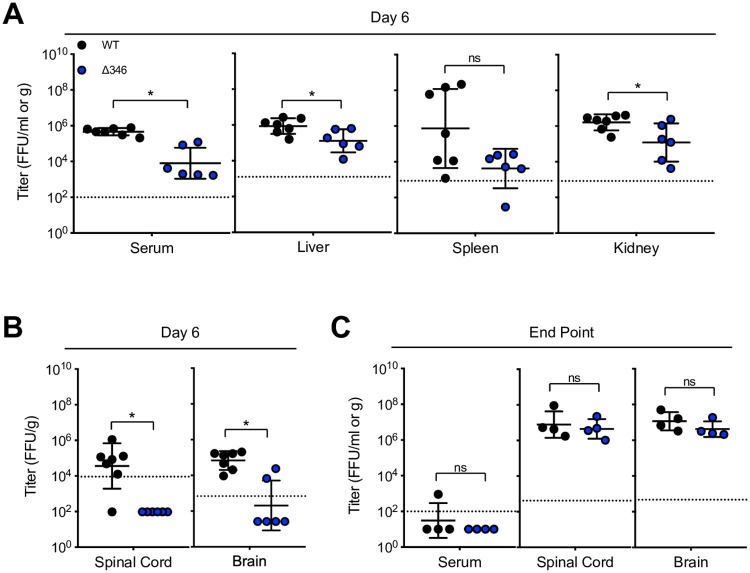
Δ346 mutant is attenuated early but reaches similar end point titers in immunocompromised mice.IFNAGR-/- mice were infected with 103 FFU of WT or Δ346 ZIKV via footpad infection. On day six post infection, (A) serum, liver, spleen, kidney, (B) spinal cord, and brain were harvested and titered for infectious virus levels (n = 7 WT and n = 6 Δ346 ZIKV infected mice). Moribund mice were harvested for (C) serum, spinal cord, and brain end-point titer analysis (n = 4 for each group). Mann-Whitney tests were performed on log-transformed data. * represents p < 0.05. Dotted line represents limit of detection. Data points not detected are plotted at half the limit of detection. Error bars represent standard deviation.